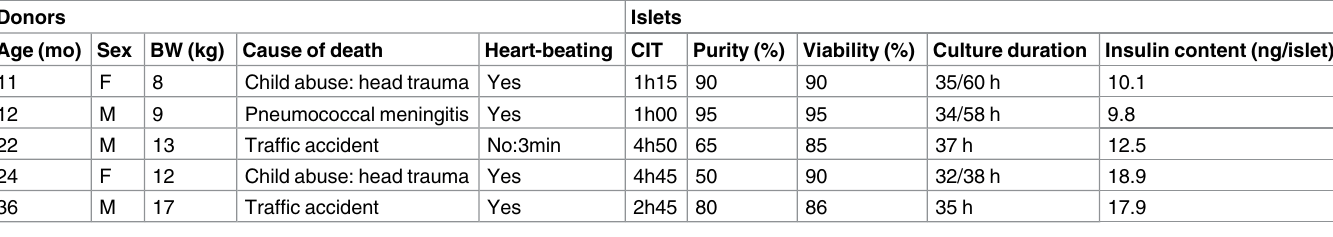
Table 1. Characteristics of infant donors and of their isolated islets. Donors Islets Age (mo) Sex BW (kg) Cause of